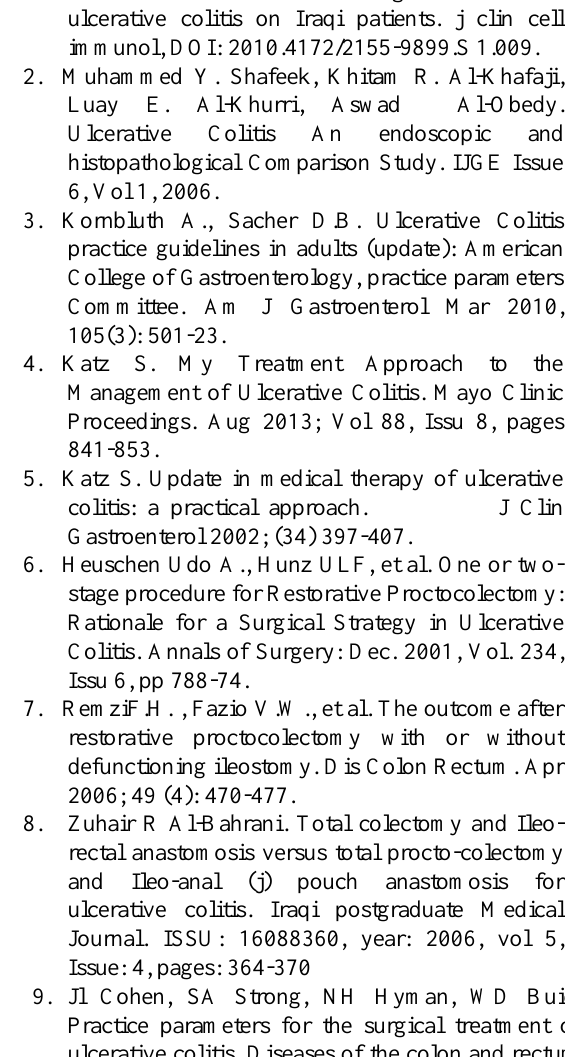
histopathological Comparison Study. IJGE